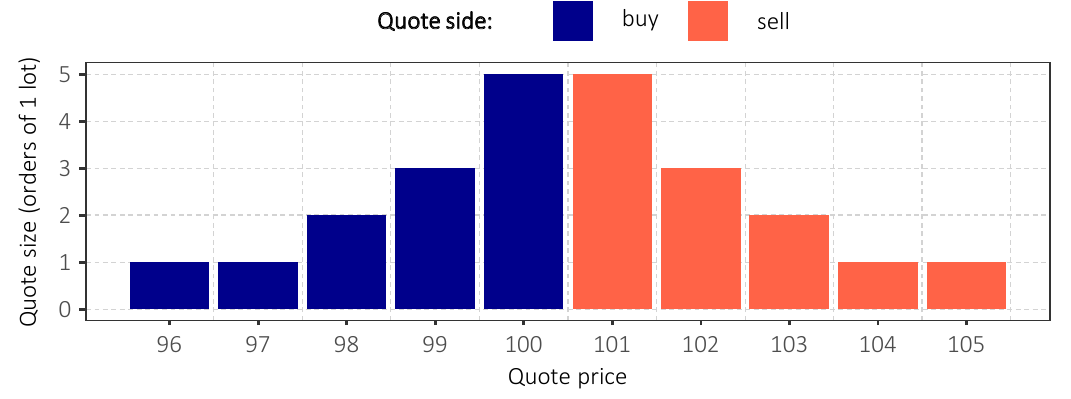
Figure 1. Initial shape of order book